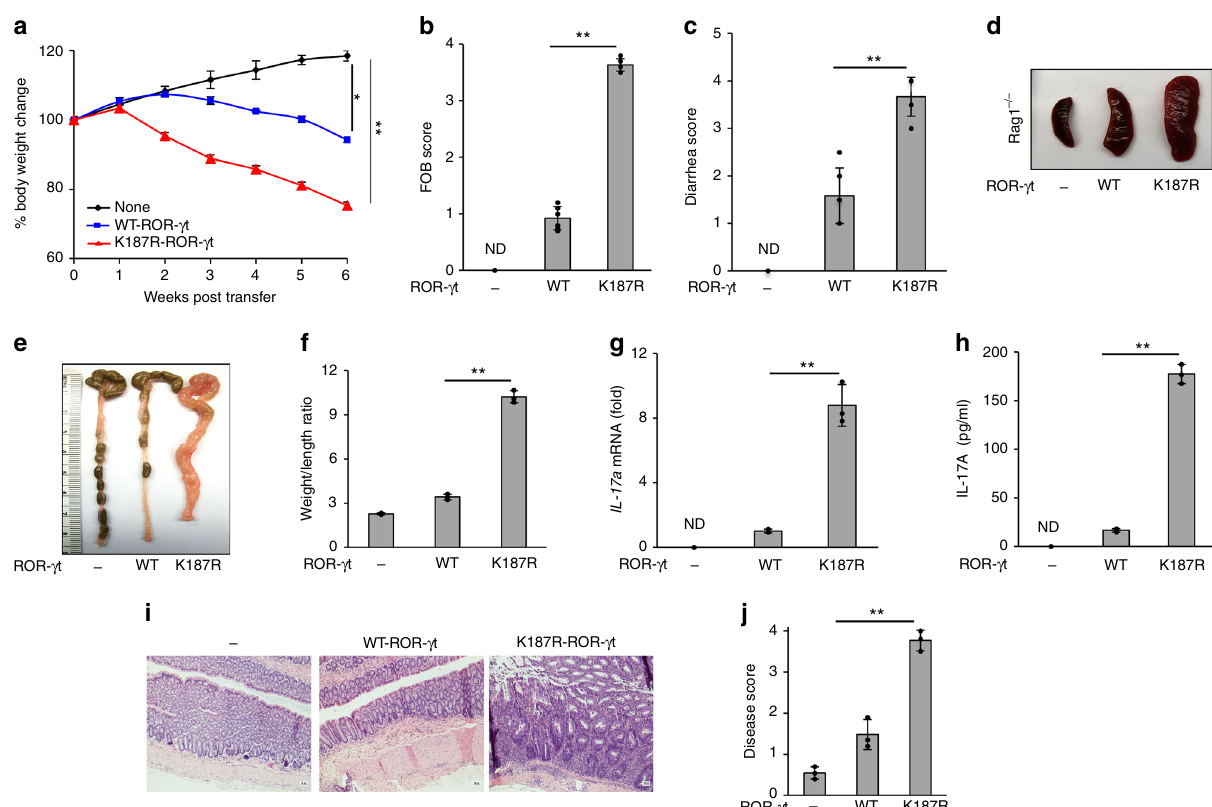
Fig. 3 Th17 cells expressing SUMOylation-defective ROR- γ t induce severe colitis in mice. ROR- γ t – / – CD4 + T cells transduced with lentivirus expressing WT-ROR- γ t or a SUMOylation-de fi cient mutant ROR- γ t were grown under Th17-polarizing conditions and adoptively transferred to Rag1 – / – mice. Data shows a body weight, b fecal occult blood score, c diarrhea score, d spleen size, and e , f colonic weight-to-length ratio for Rag1 – / – mice ( n = 4 per group) given an intraperitoneal injection of ROR- γ t – / – cells (None), Th17 cells expressing wild-type ROR- γ t (WT-ROR- γ t), or Th17 cells expressing SUMOylation- de fi cient mutant ROR- γ t (K187R-ROR- γ t) and monitored for 6 weeks. g Real-time PCR was used to analyze IL-17a mRNA. h ELISA was used to measure IL- 17A secretion in the explant colon culture of Rag1 – / – mice as in a – f ( n = 3). Results are presented relative to those of Rag1 – / – mice given ROR- γ t – / – cells. i Microscopy shows H&E-stained colonic sections. j Disease scores of those sections are provided from Rag1 – / – mice as in a – f ( n = 3). ND: not detected. Data are from one experiment representative of three independent experiments with similar results. * p < 0.05, ** p < 0.01 (two-tail t test) error bars are